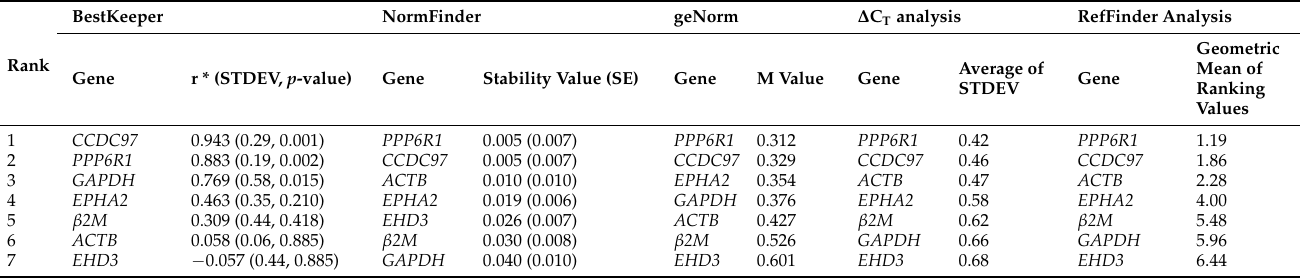
Table 4. Expression stability ranking of candidate RGs as per BestKeeper, NormFinder, geNorm, ∆ C T , and RefFinder